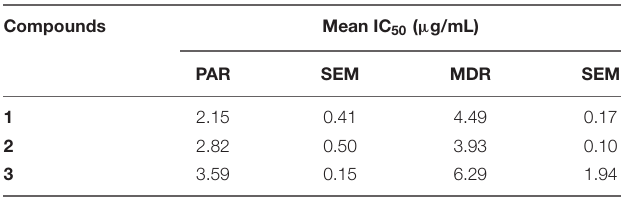
TABLE 5 | Cytotoxic effects of dimeric naphthoquinones on PAR and MDR mouse T-cell lymphoma cell lines. Compounds